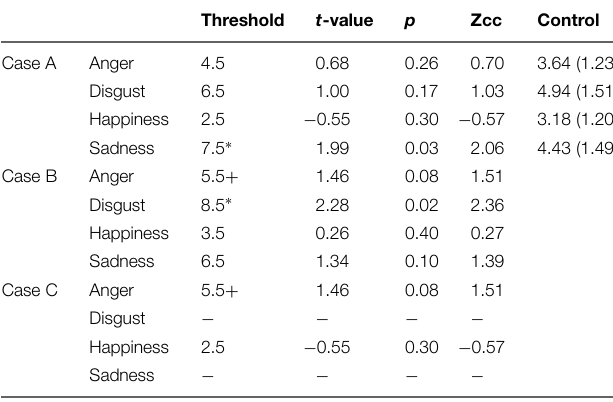
TABLE 1 | Thresholds of emotional value of the cases and healthy